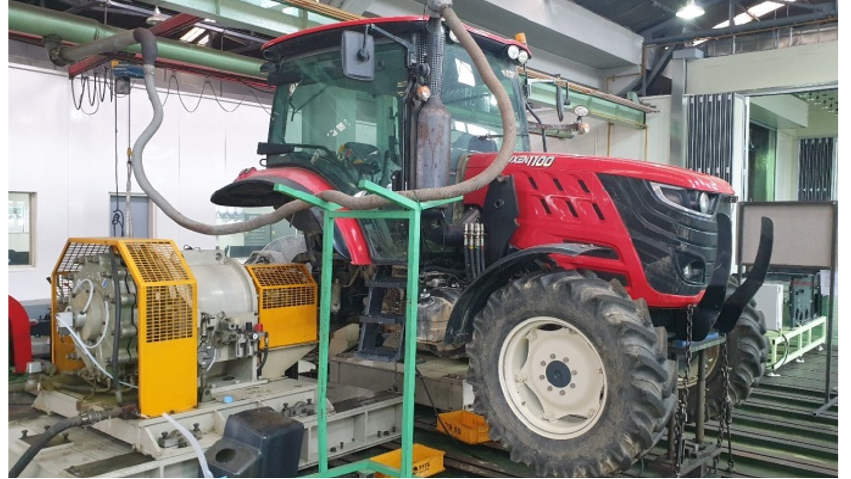
Figure 6. A photo of the axle dynamometer test bench used in this study. The axle dynamometer test was conducted under continuous equal load. The rear axles were connected to the axle dynamometer during the experiment, and load was applied to the transmission by braking with the brake in the rear axle. The load applied to the rear axles was determined based on the tractor weight, weight distribution ratio, maximum slip torque, and reduction ratio. The maximum slip torque was calculated using Equation (1) below. The weight distribution ratio of the rear axle was 0.6 according to the